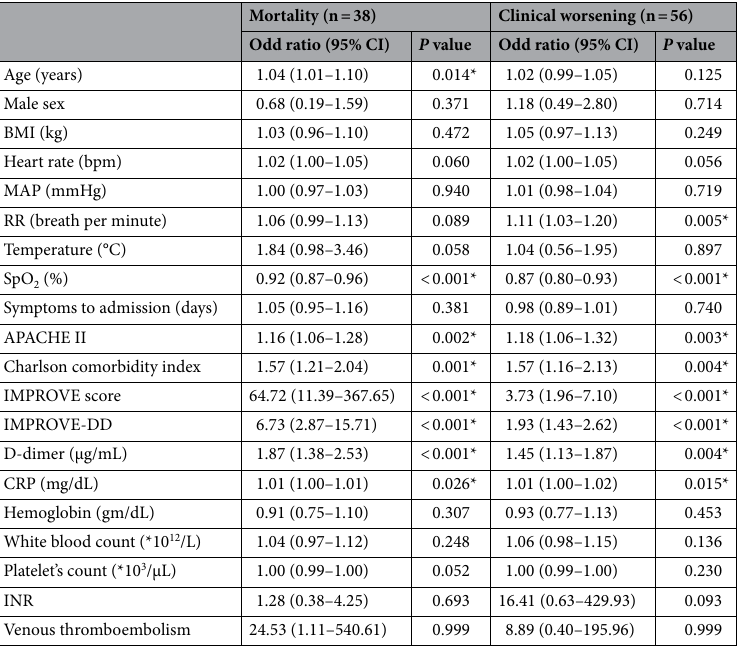
Table 3. Univariate analysis for in-hospital mortality and clinical worsening. APACHE II acute physiology and chronic health evaluation II, BMI body mass index, CI confidence interval, CRP C-reactive protein, DD D-dimer, IMPROVE international medical prevention registry on venous thromboembolism, INR international normalized ratio, MAP mean arterial pressure, RR respiratory rate, SpO 2 peripheral oxygen saturation.